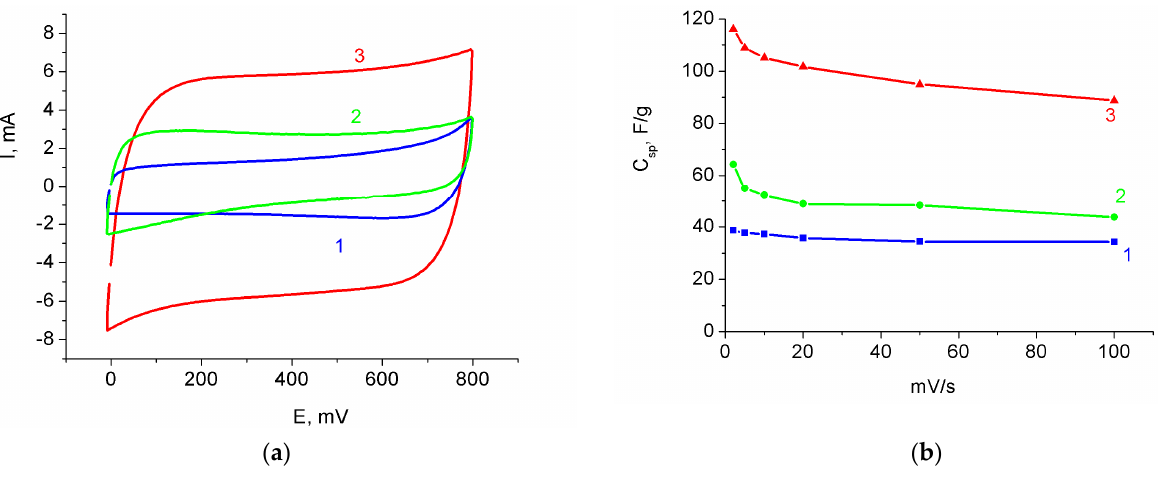
Figure 8. ( a ) CV curves for the original electrode (1), oxidized (2), and treated in permanganate solution (3). ( b ) Dependences of capacities on scanning rate.